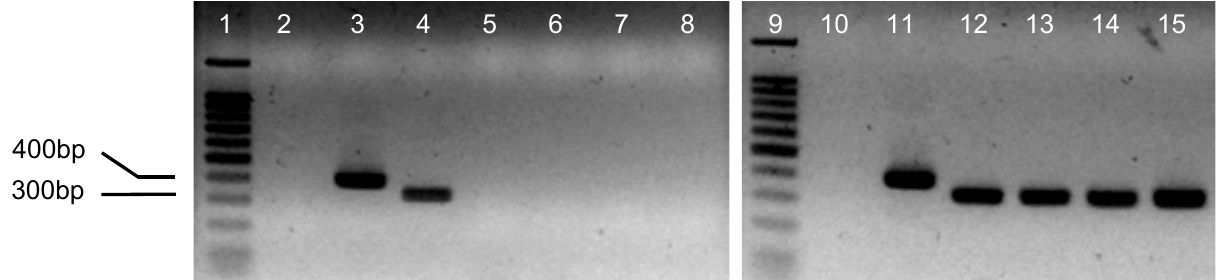
Figure 3. Detection of CMV satellite RNA in potato and tobacco samples infected with CMV. Lane 1, 9 , 100bp DNA ladder; 2, 10 , healthy tobacco cv. White Burley; 3, 11 , tobacco cv. White Burley infected with SatRNA 55-1 (positive control); 4, 12 , original infected potato with PoCMV7-5; 5 , original infected potato with 7-7; 6 , original infected potato with 5-1; 7 , original infected potato with 5-2; 8 , original infected potato with 5-3; 13 , tobacco cv. Xanthi infected with PoCMV7-5; 14 , tobacco cv. White Burley infected with PoCMV7-5; 15 , potato cv. Maris Bard infected with PoCMV7-5.